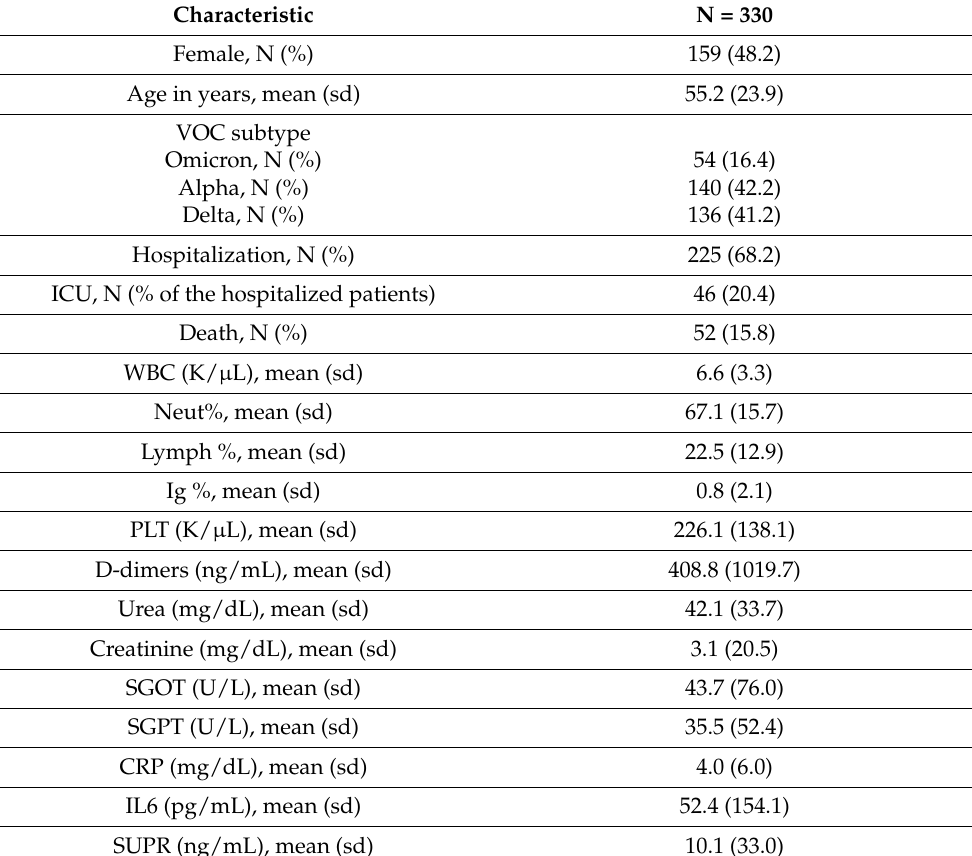
Table 1. Descriptive statistics for demographic and clinical characteristics of our